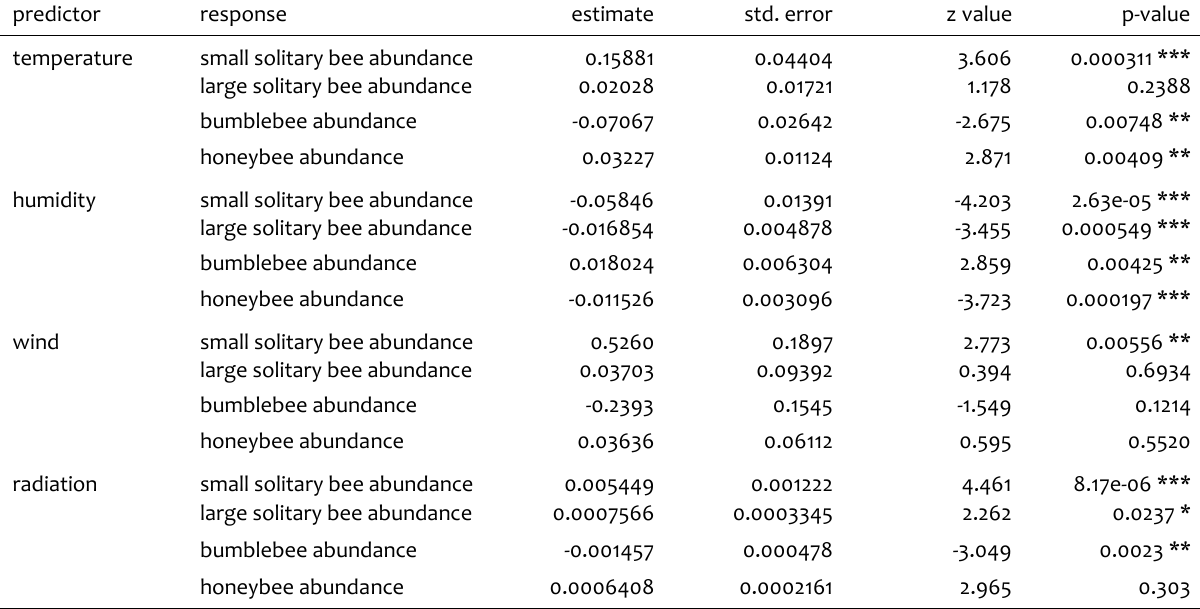
Table 9. Results of poisson regression models assessing the effect of temperature at 2 m elevation, relative humidity, wind, and global radiation on wild bee and honeybee abundance on fruit tree flowers. Each predictor and bee type represents a separate model. Estimated parameters, standard errors, z-values and p-values are given. Significance is marked with * at P  0.05, ** at P  0.01 and *** at P  0.001.